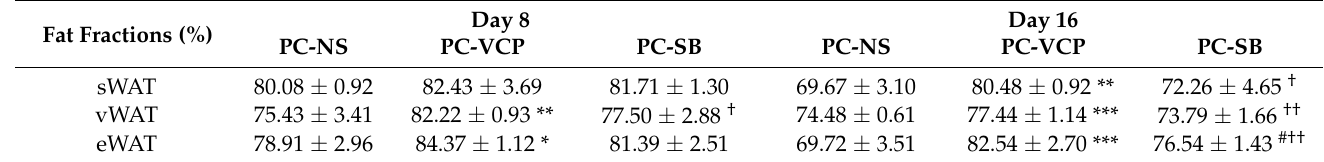
Table 2. MRI-measured fat fractions of sWAT, vWAT and eWAT at different time points of